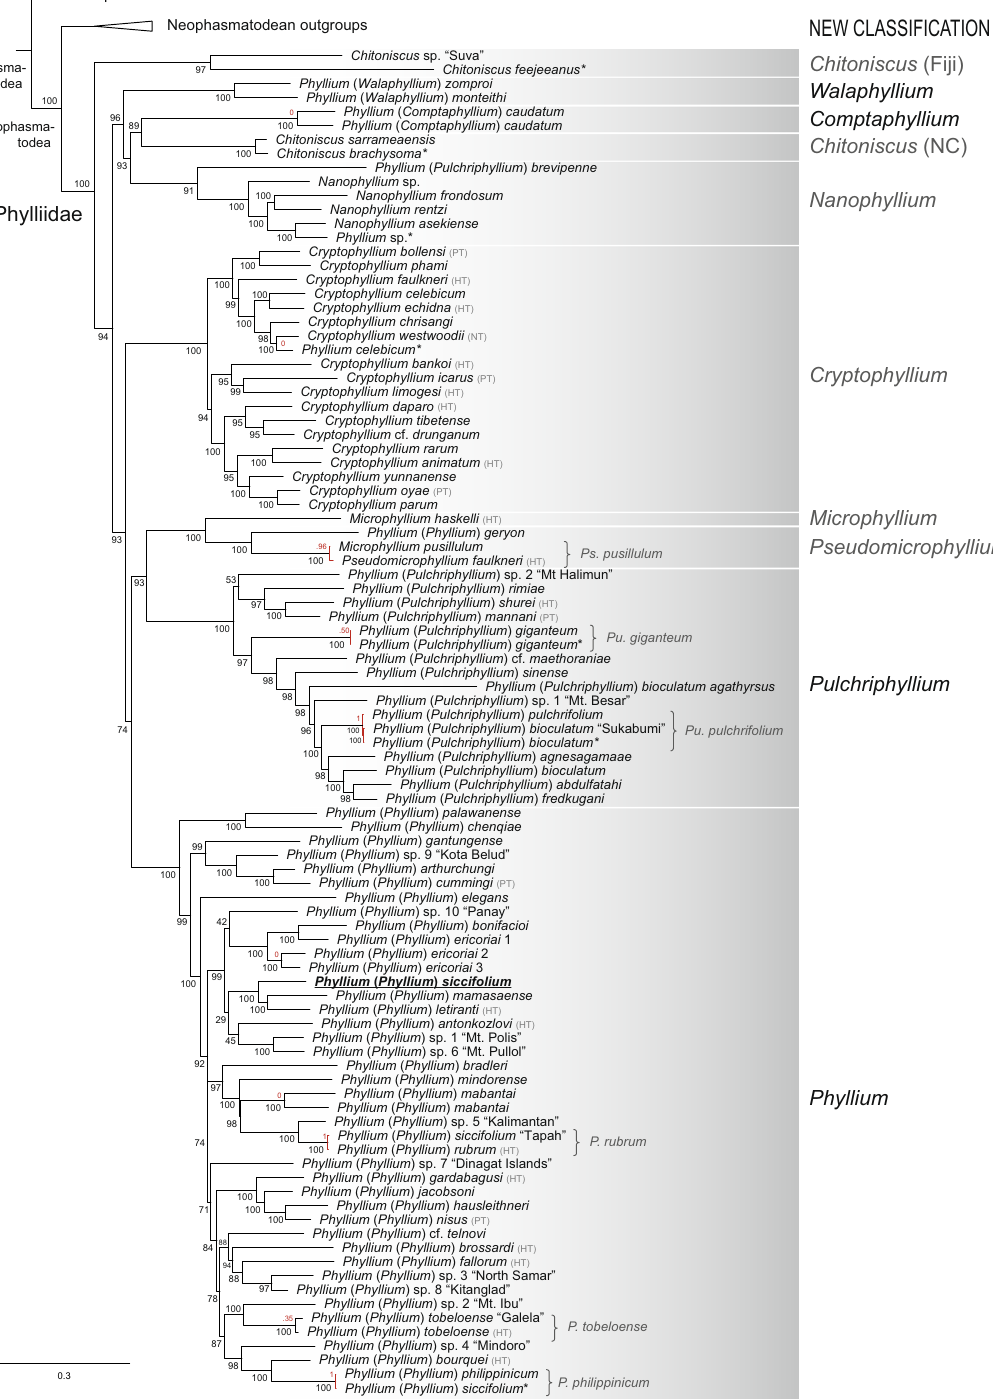
Fig. 2 Maximum likelihood (ML) phylogenetic relationships of Phylliidae. The topology is derived from the best-scoring ML tree in IQ-TREE using six nuclear and mitochondrial loci. UFBoot node support values are depicted at each node. The probability values resulting from the species delimitation analysis are shown in red (red branches if specimens were estimated to be the same species). The new generic classi fi cation following our results is presented on the right. The Phyllium type species ( P. siccifolium ) is underlined and noted in bold. HT holotype, NT neotype, PT paratype, NC New Caledonia. *Data solely obtained from